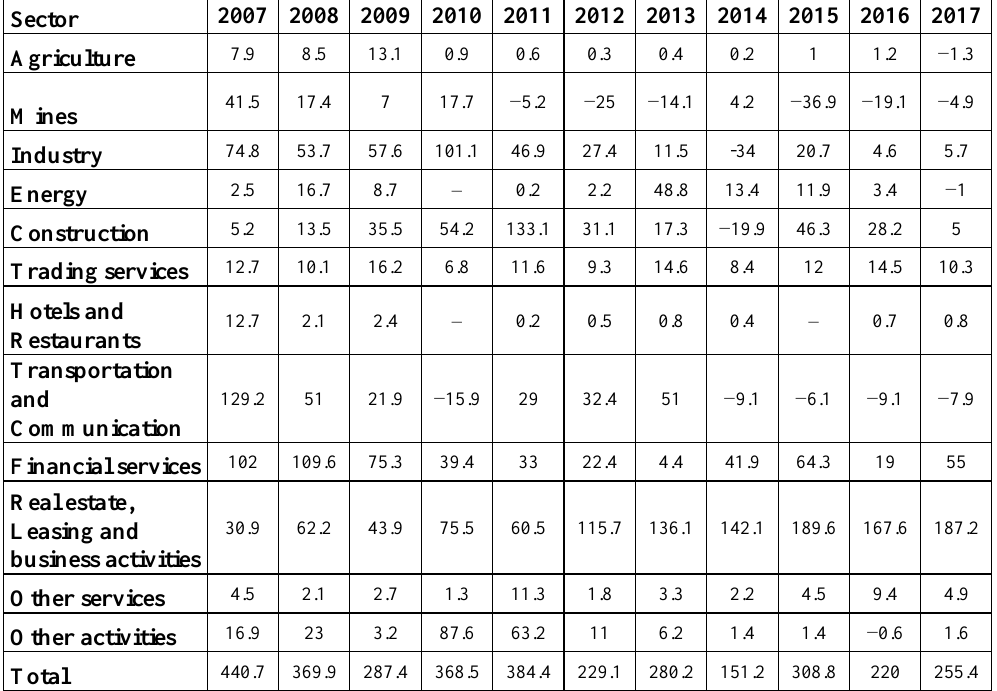
Table 1. FDI in Kosovo by Economic Activity, in millions of euros (CBK, 2018)